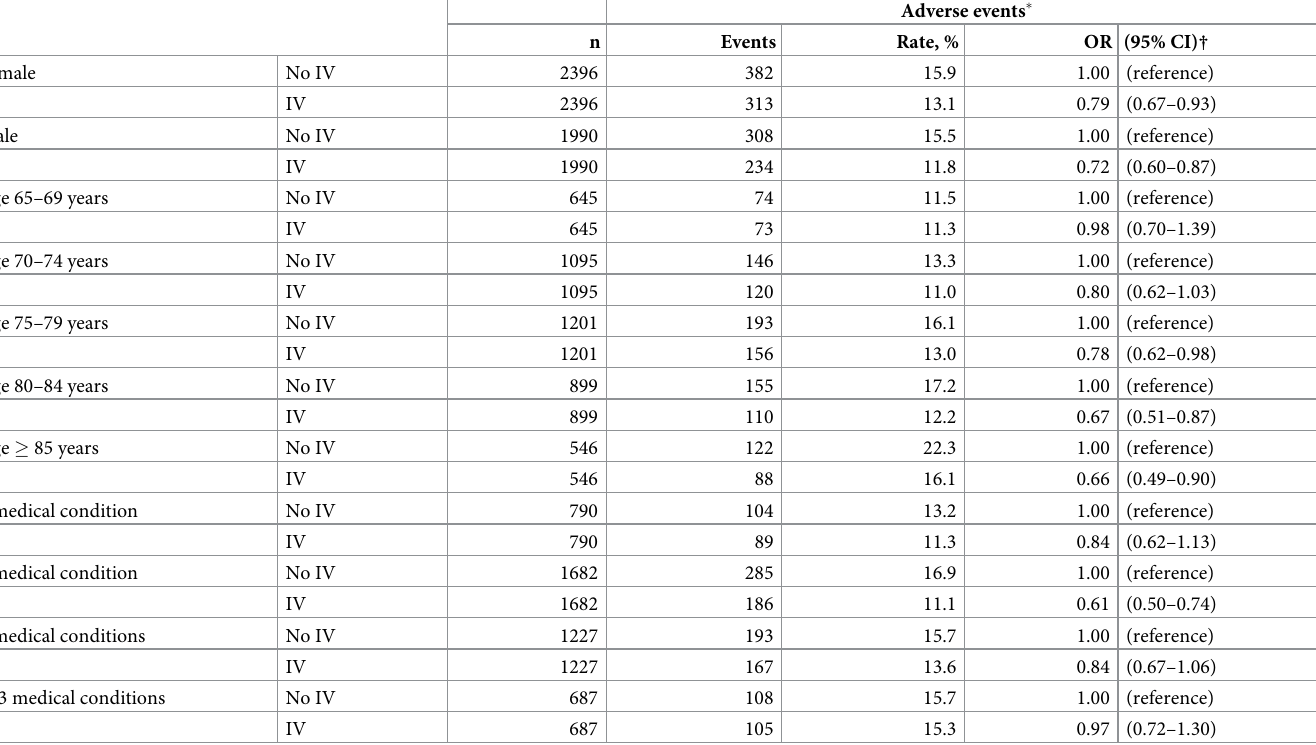
Table 4. The stratified analysis for the risk of adverse events during hospitalization of kidney disease associated with influenza vaccination (after propensity-score